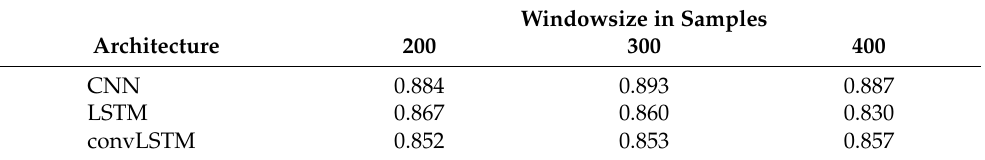
Table A2. Training results for different deep learning architectures and varying window sizes between one and two seconds. All models were trained and optimized as described in Section